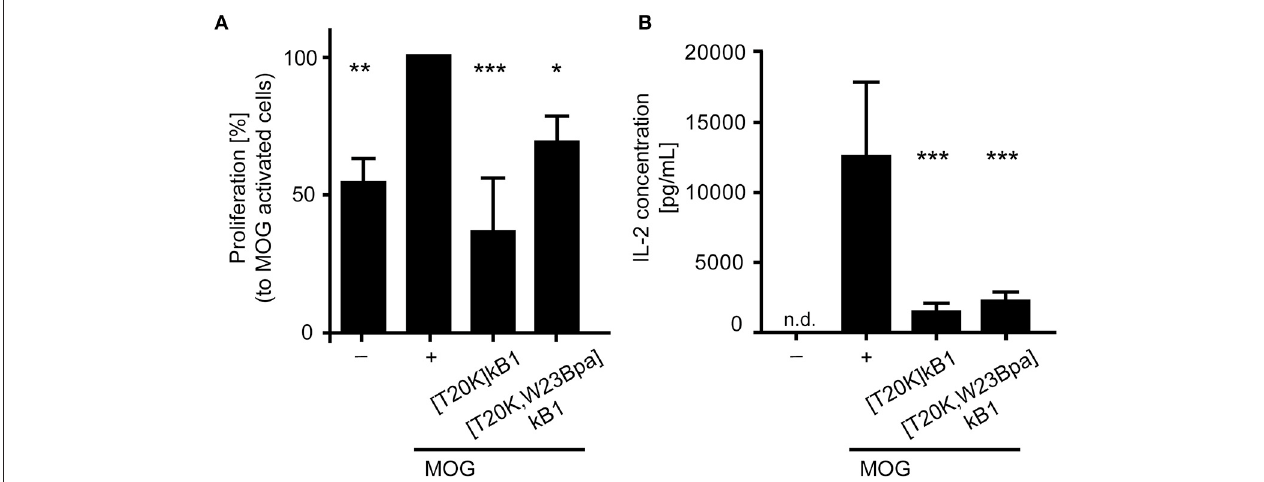
FIGURE 3 | Biological activity of the circular peptide probe. Bioactivity was assayed by (A) anti-proliferation assays of myelin oligodendrocyte glycoprotein (MOG)-immunized mouse splenocytes and (B) extracellular IL-2 cytokine levels of MOG-activated splenic cells from 2D2 mice. The cyclotide probe [T20K,W23Bpa]kalata B1 (kB1) was measured in comparison to [T20K]kB1 (4 µ M each), a MOG-stimulated positive control ( + ) and an unstimulated cell only control ( − ). The proliferation data are normalized relative to the MOG-stimulated control. Data are shown as mean ± S.D. of three independent biological experiments. Significance was evaluated using one-way ANOVA with Bonferonni or Dunnett’s Post-Hoc test (* P < 0.05, ** P < 0.01 and *** P < 0.001); n.d., not